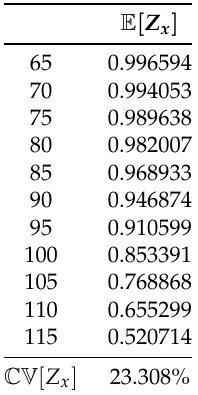
Table 3. Gompertz-Gamma model: expected value and coefficient of variation of the frailty at age x . General population.